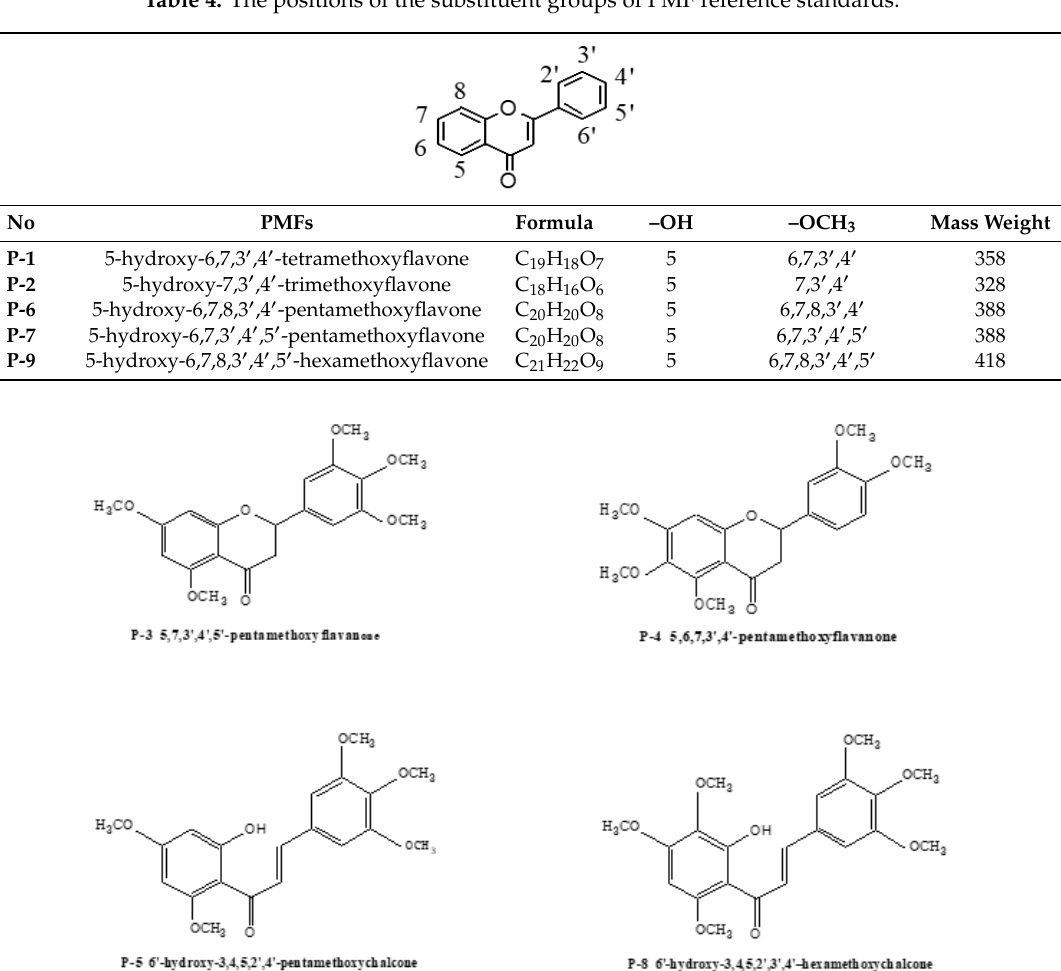
Figure 7. Structures of the nine PMFs reference standards.